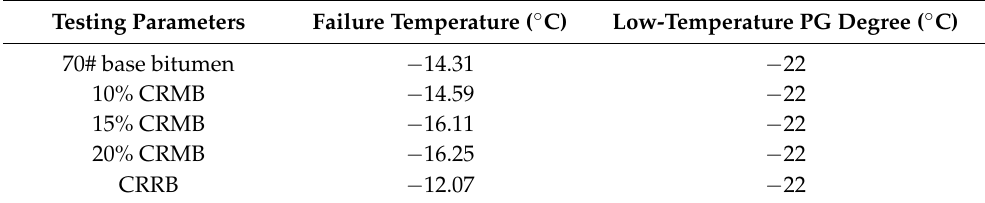
Table 4. Failure temperature and PG grade of bitumen at low temperature. Testing